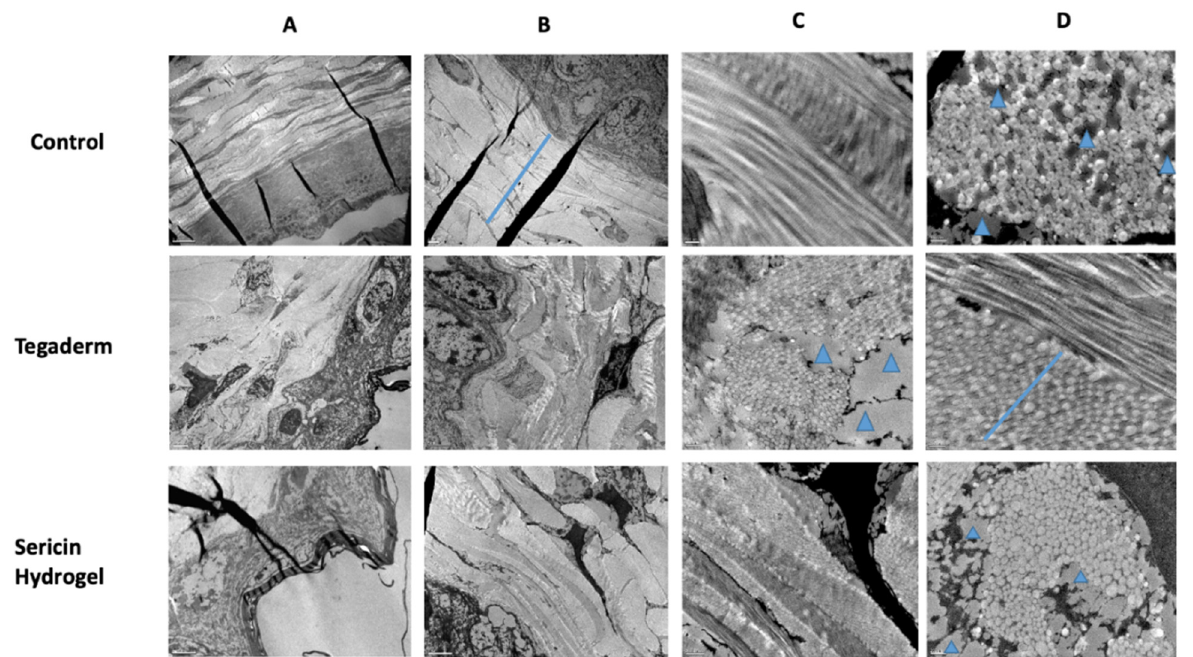
Figure 7. Representative images of TEM to analyze the collagen fibers at the wound bed on diabetic animals that were treated with sericin hydrogel and covered with Tegaderm, wounds only covered with Tegaderm, or wounds that were left untreated (control), in an animal model of a skin wound healing assay. ( A ) Dermis organization at low magnification (dermis-blue bar); ( B ) The network of collagen fibers; ( C ) Orientation and distribution of collagen fibrils (blue arrow head-lipid droplets; and ( D ) Diameter of collagen fibers.